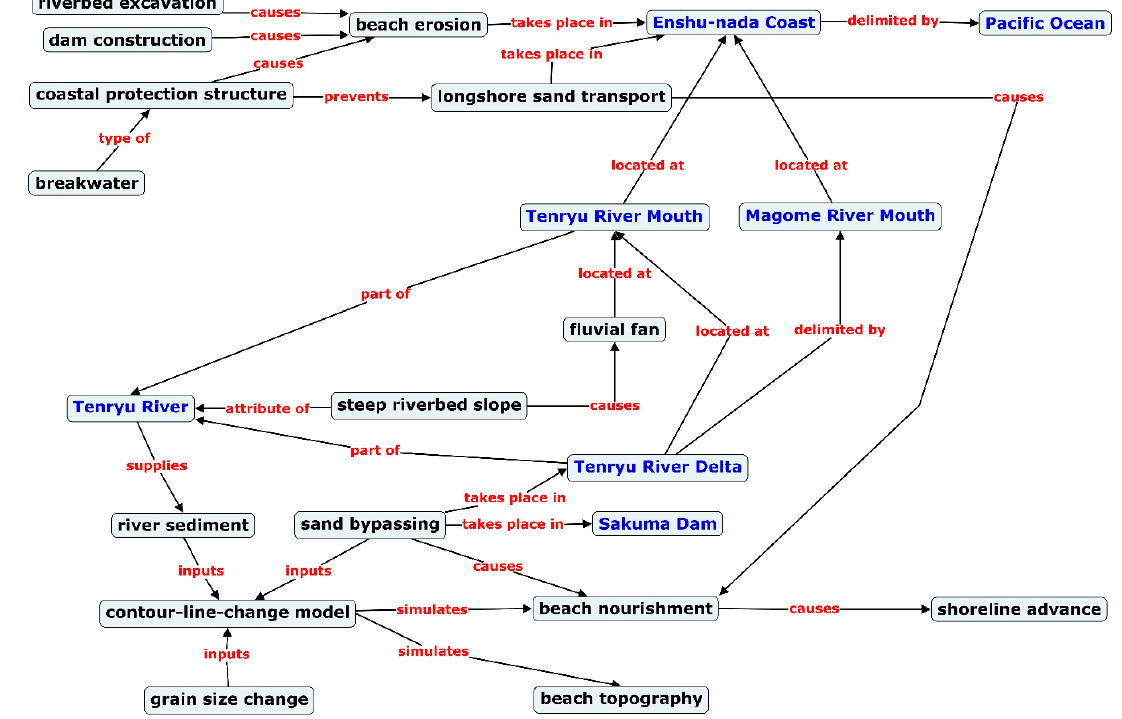
Figure 6. Semantic network of the terms associated with the Tenryu and Magome rivers.